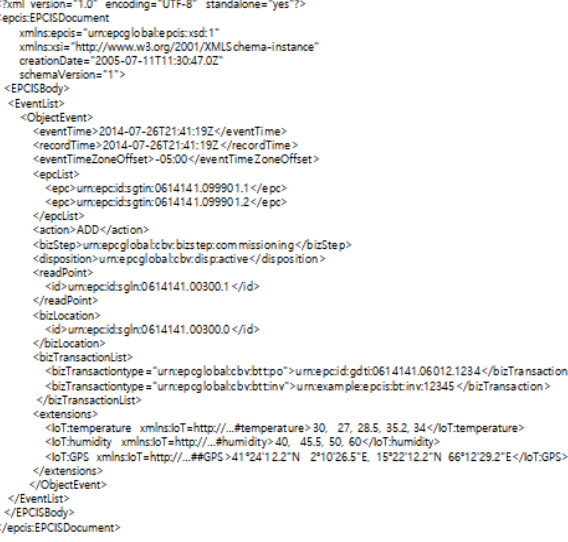
Figure 7. Example of XML event log data.